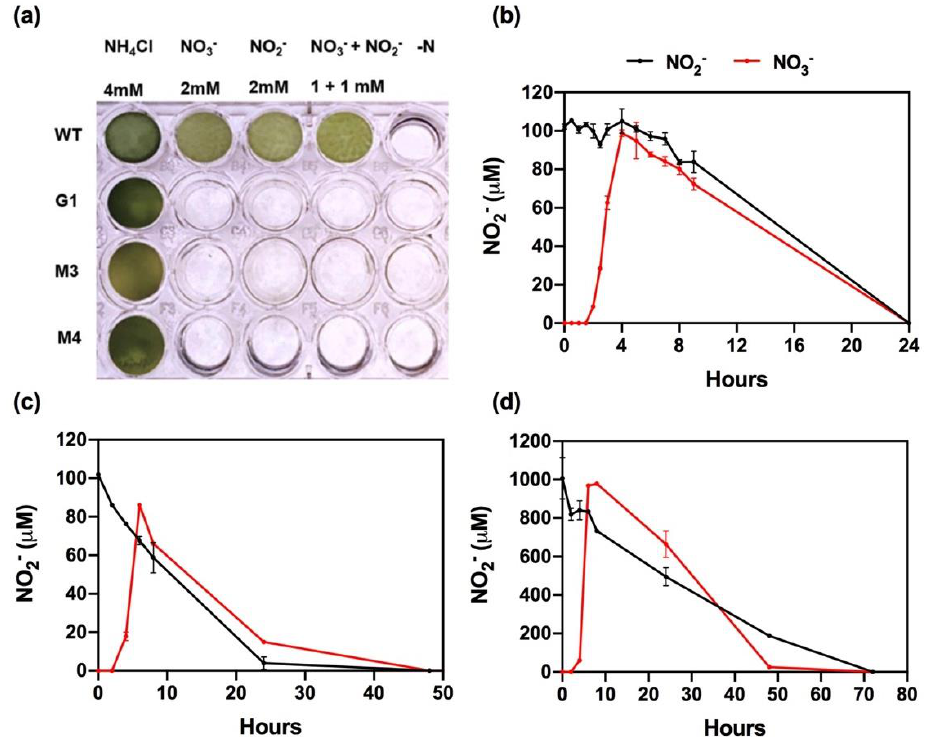
Figure 1. M3 strain cannot grow in NO 3 − or NO 2 − but metabolizes them. ( a ) Growth test of the nii1 mutants (G1, M3, and M4) and the WT (6145c) strain on the indicated N sources. Plate wells were inoculated with 0.1 × 10 6 cells ml − 1 and cultured for 7 days. ( b – d ) Extracellular NO 2 − quantification in cultures incubated in the presence of either NO 3 − (red line) or NO 2 − (black line). NH 4+ -grown cells were washed and transferred to NO 3 − - or NO 2 − -containing media at 0.1 mM in non-sealed bottles ( b ), 0.1 mM in sealed bottles ( c ), or 1 mM in sealed bottles ( d ). Error bars represent ±SD, n ≥ 3.